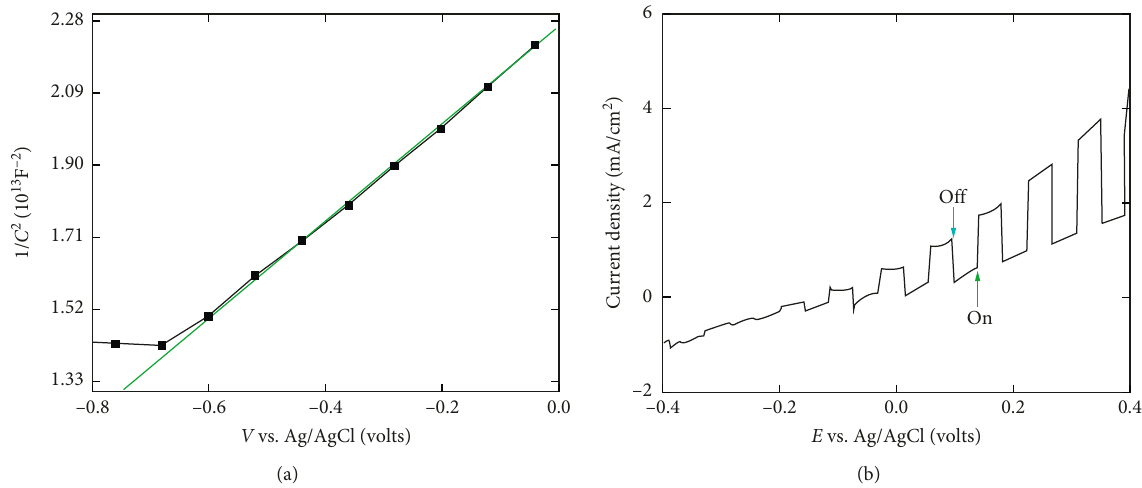
Figure 3: (a) Mott–Schottky plot and (b) linear sweep voltammetry measurement of Cu